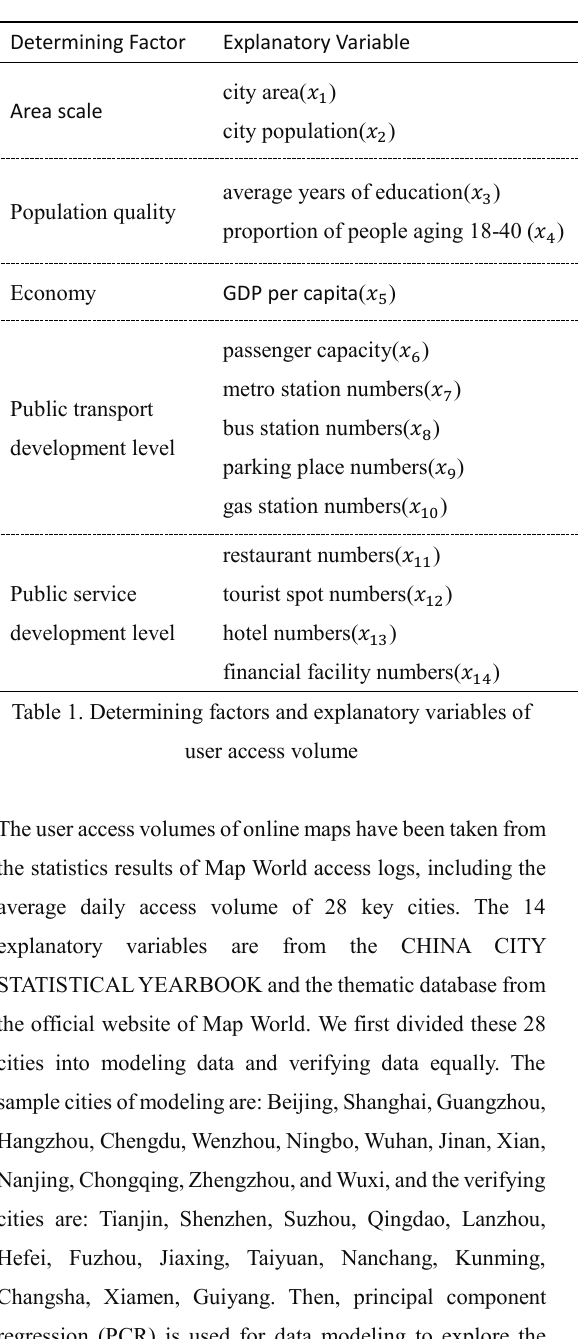
Table 2. Correlation coefficient matrix of determining